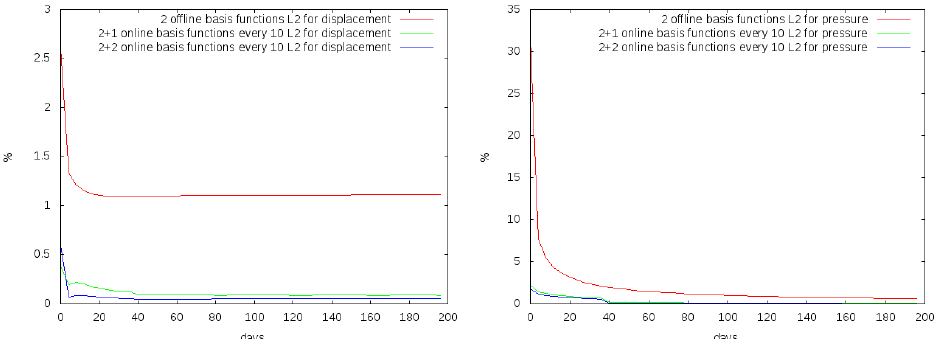
Figure 12. Case 1 . Relative L 2 error vs. time with M of f = 2 for displacements ( left ) and pressure ( right ). M on = 0 (red), M on = 1 (green), and M on = 2 (blue). Updated at every 10 time steps.